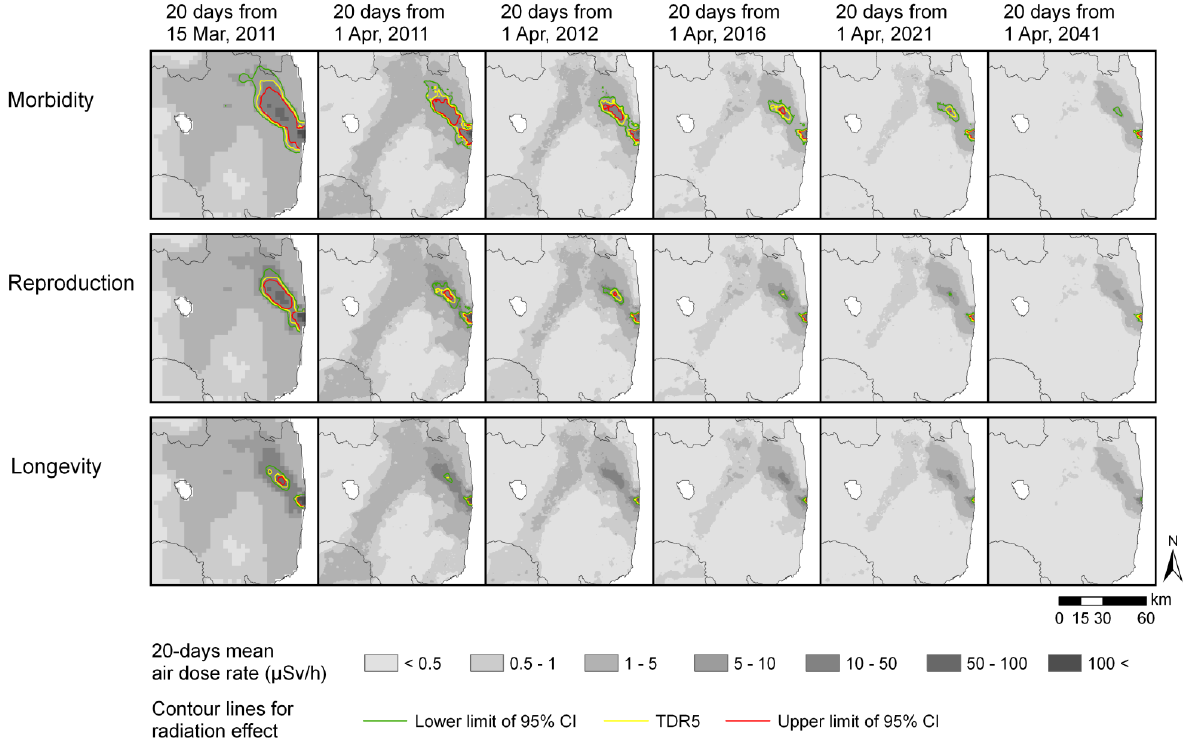
Figure 3. Radiation effect maps for morbidity, reproduction, and longevity in vertebrates subject to chronic exposure around the Fukushima NPP. We drew the contour lines using the 5% threshold dose rate estimation (TDR5) and 95% CI of the thresholds suggested by Sazykina et al. (2009) on a map of the 20-day mean air dose